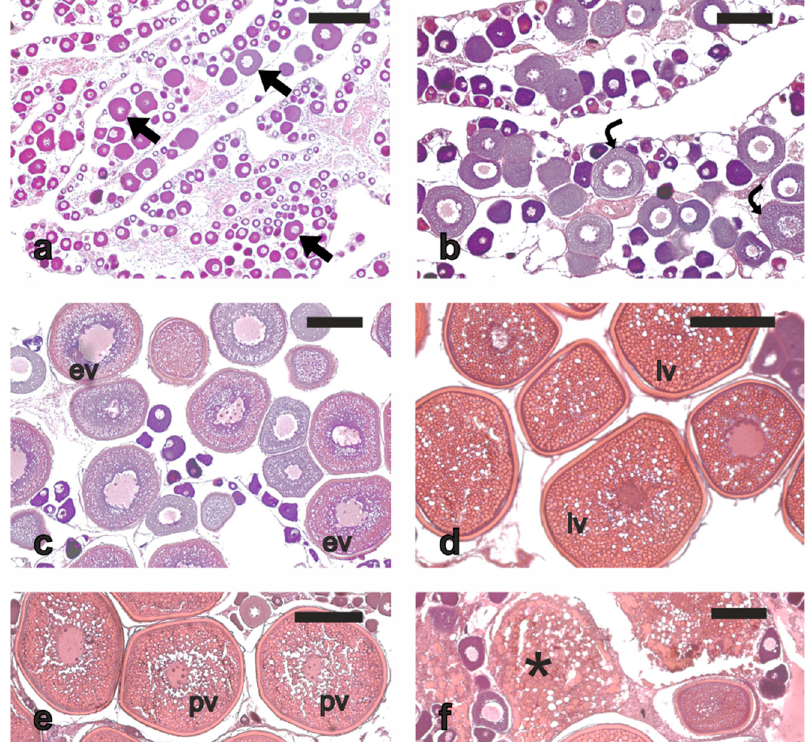
Figure 4. Micrographs of ovary sections from cage ‐ reared meagre in different reproductive conditions . ( a ) Ovary from a quiescent fish sampled in April showing the perinucleolar stage as most advanced oocyte stage. ( b ) Oocytes at cortical alveoli stage in the ovary of a specimen sampled in April. ( c ) Early vitellogenic oocytes in the ovary of a fish sampled in April. ( d ) Late vitellogenic oocytes in the ovary of a meagre sampled in June. ( e ) Early post ‐ vitellogenic oocytes, characterised by initial coalescence of yolk platelets and lipid droplets, in the ovary of a fish sampled in June. ( f ) Atretic vitellogenic follicles in the ovary of a fish sampled in June. Haematoxylin ‐ eosin staining. Magnification bars: 250 μ m. Arrow, perinucleolar stage oocyte; asterisk, α atretic oocyte; curved arrow, oocyte at cortical alveoli stage; ev, early vitellogenic oocyte; lv, late vitellogenic oocyte; pv, post vitellogenic oocyte.